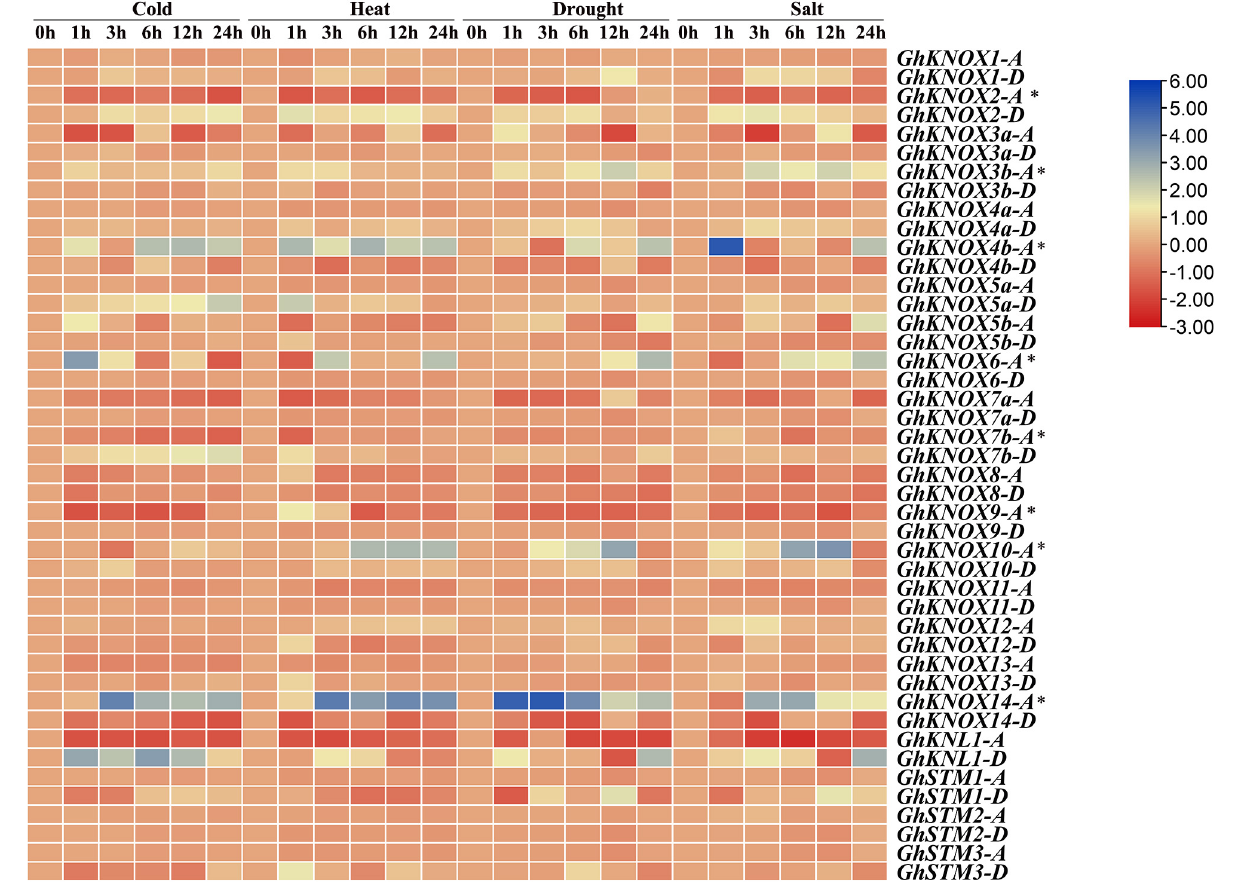
FIGURE 6 | Expression profiles of GhKNOX genes in response to four abiotic stress treatments. The ratios of FPKM between the treatments (at 1, 3, 6, 12, and 24 h) and the control (at 0 h) were calculated from RNA-seq data and are shown as a heat map. The colored scale indicates the relative expression level. An asterisk indicates that expression of these genes requires verification by